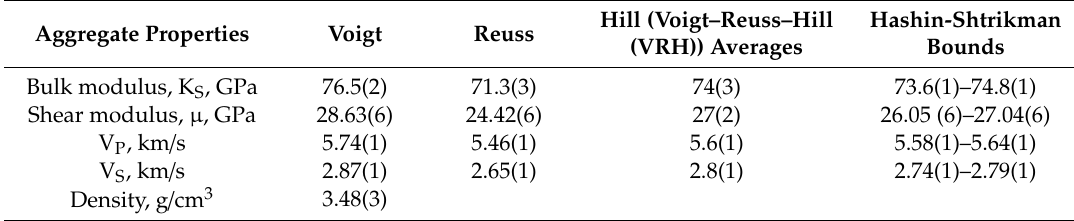
Table 4. Isotropic aggregate elastic properties of